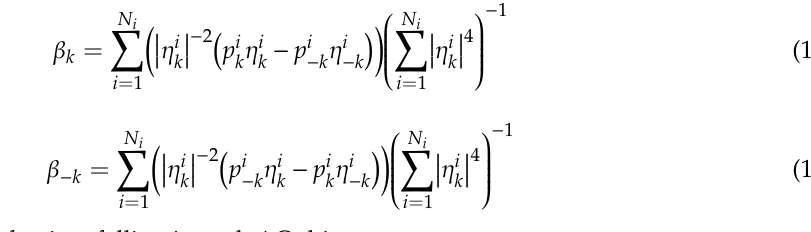
Figure 2. A typical snapshot of tracers in the WBL above waves. The picture is seven times stretched in a vertical direction.